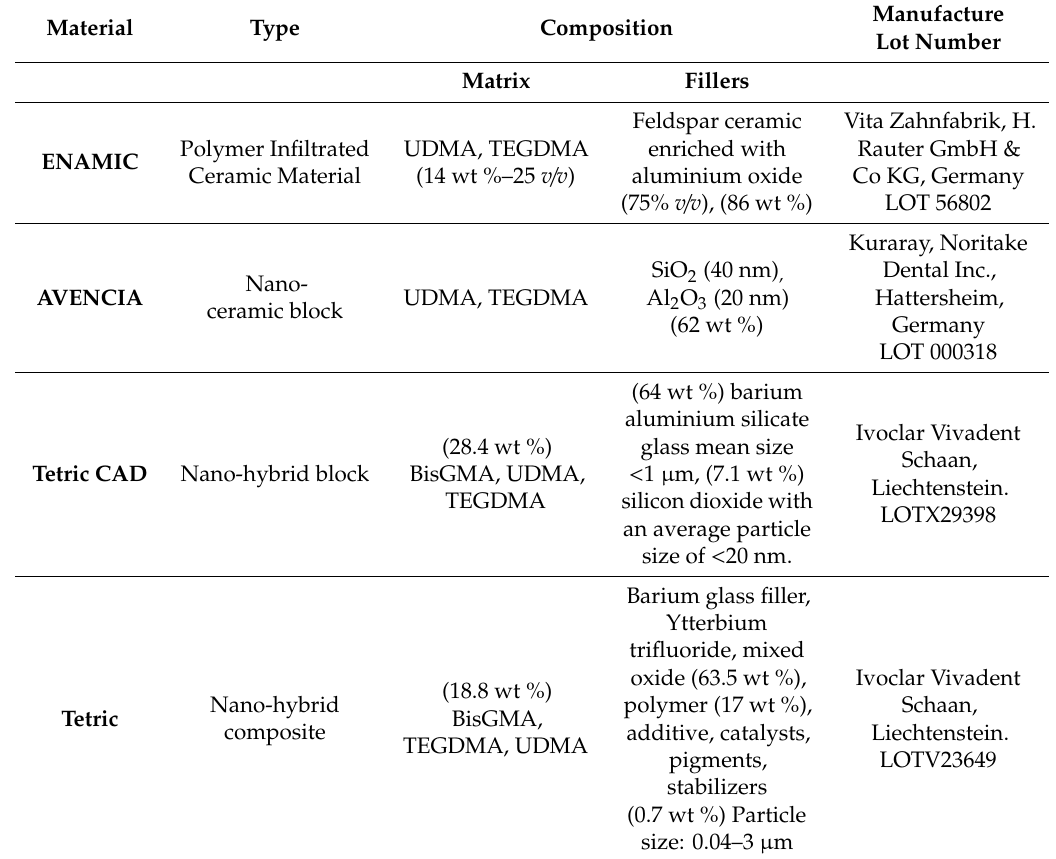
Table 1. Composition of the materials